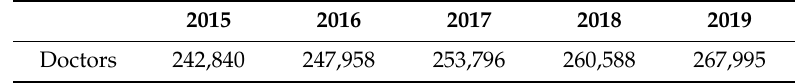
Table 1. Number of doctors registered at the Spanish o ffi cial medical colleges. Series 2015–2019.